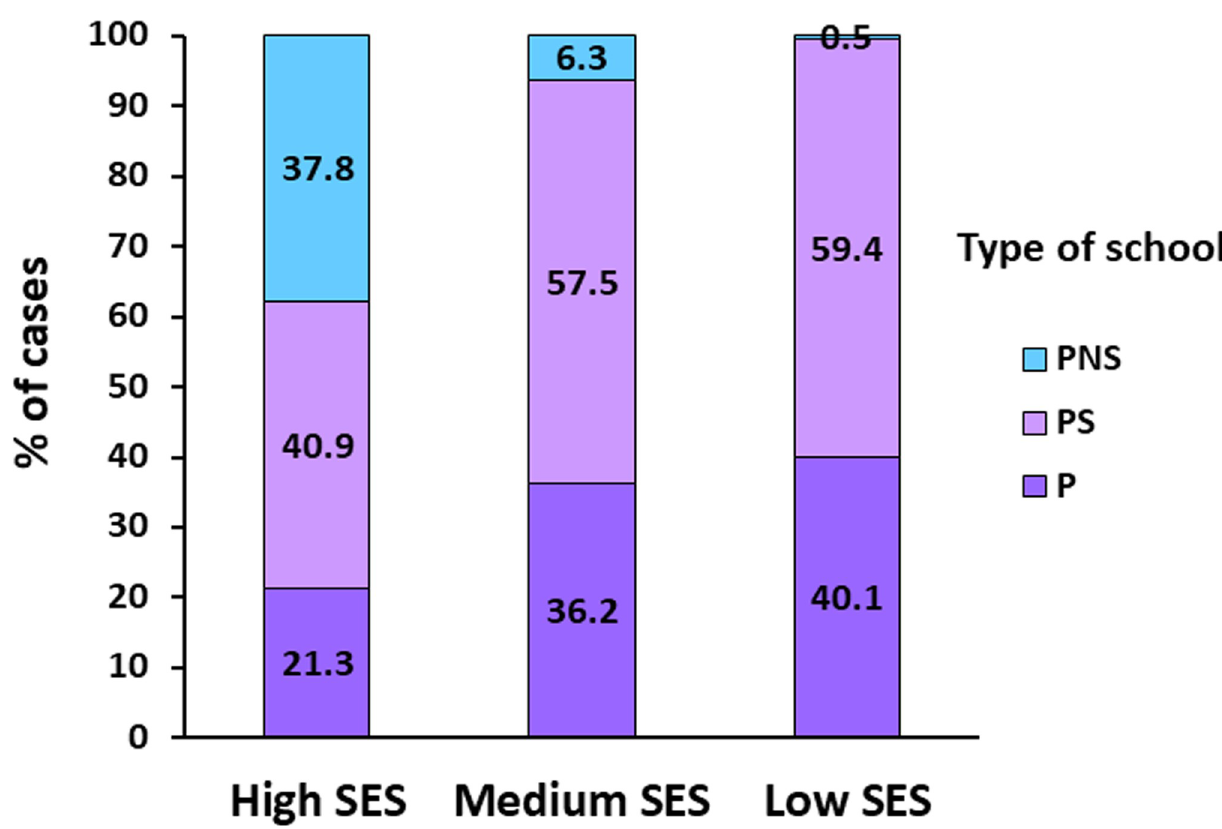
Fig 4. Distribution of the sample by type of school and socio-economic status (SES). Note . P = public; PS = private subsidized; PNS = private non- subsidized. ( n = 1,353). X 2 o (4df) = 268.808 > X 2 t (4df) p < .001 =